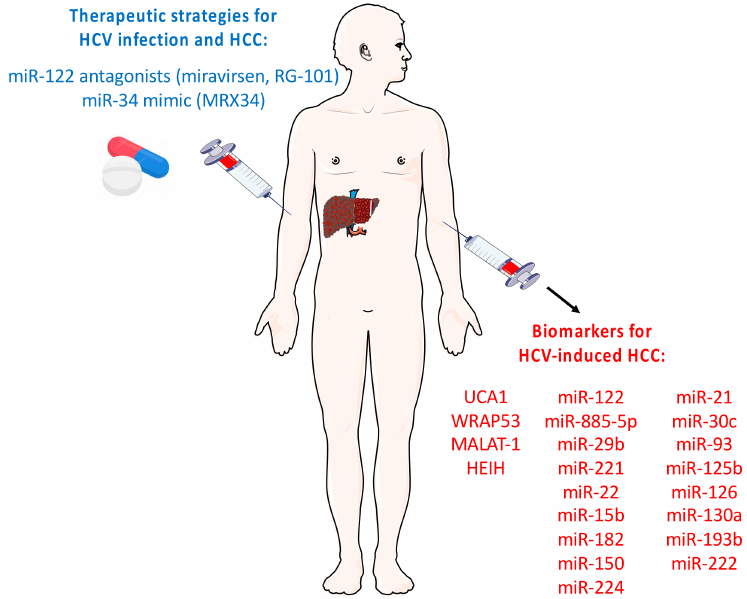
Figure 2. Schematic representation of the potential use of ncRNAs as therapeutic targets for HCV infection and HCC or biomarkers for HCV-induced HCC. MiR-122 antagonists miravirsen and RG-101 have been shown to lead to a dose-dependent reduction of viral RNA in CHC patients [108,109]. miR-34 mimic (MRX34, Mirna Therapeutics) has been administred to patients with primary liver cancer, but this trial was abrogated due to immune-related adverse effects. LncRNAs and miRNAs that have been suggested as biomarkers for HCV-induced HCC are also indicated [42,72,74,111]. HCV: hepatitis C virus. HCC: hepatocellular carcinoma. Images were adapted from SMART (Servier Medical